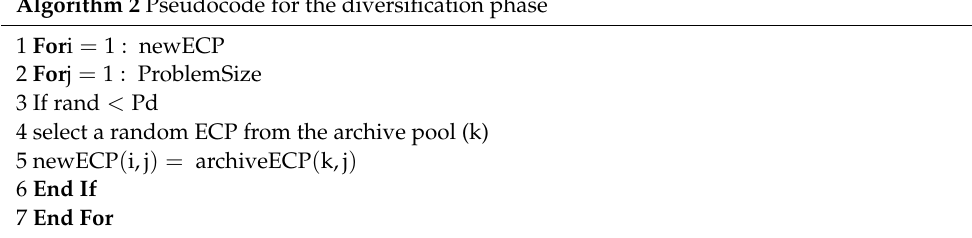
Algorithm 2 Pseudocode for the diversification